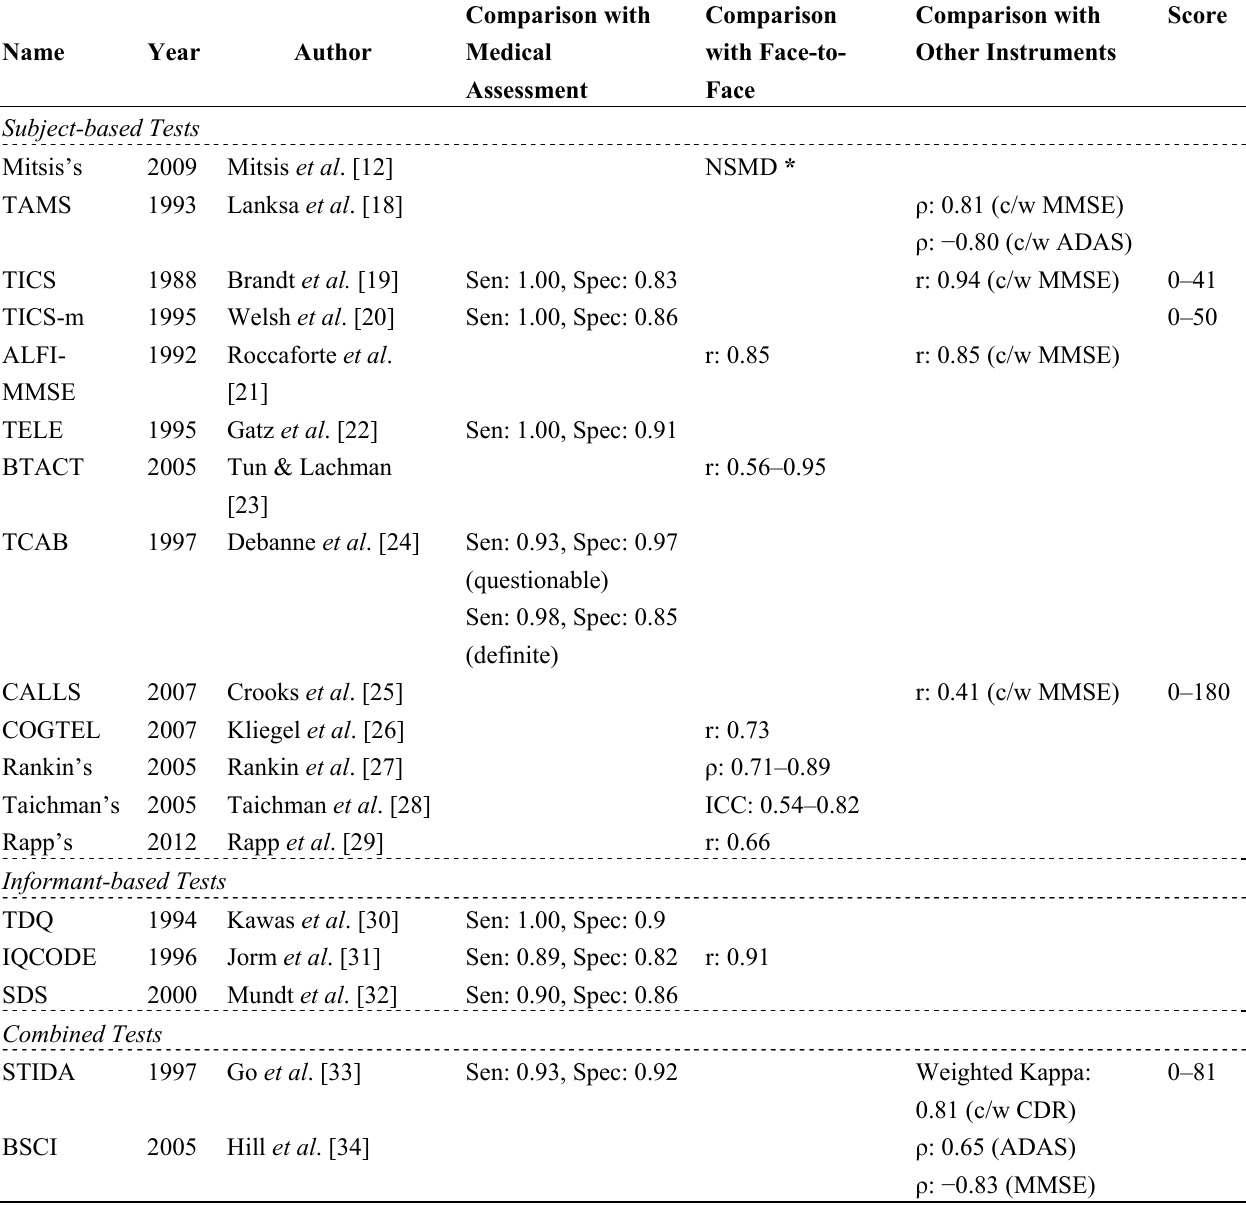
Table 2. Validity of cognitive assessment tools administered via telephone (N =